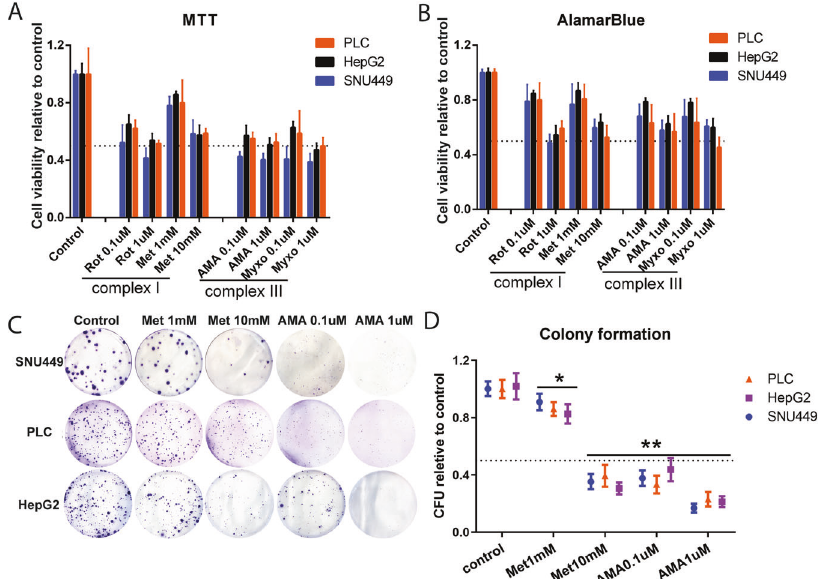
Fig. 1 Complex I and III inhibitors of mitochondrial electron transport chain (mETC) inhibited growth of HCC cells. A , B HepG2, PLC/PRF/5, and SNU-449 cells were treated for 48 h with the mETC complex I inhibitors (ROT Rotenone, Met Metformin) and complex III inhibitors (AMA Antimycin A, MYXO Myxothiazol) at different concentrations. Cell viability was quanti fi ed by MTT and Alamar Blue ( N = 9). C , D HepG2, PLC/ PRF/5, and SNU-449 cells were treated with Met and AMA at different concentrations, and the colony formation ef fi ciency was calculated ( N = 9). P -value was calculated by comparing with corresponding controls. Results are expressed as mean ± SD, and group differences were tested by Mann – Whitney U